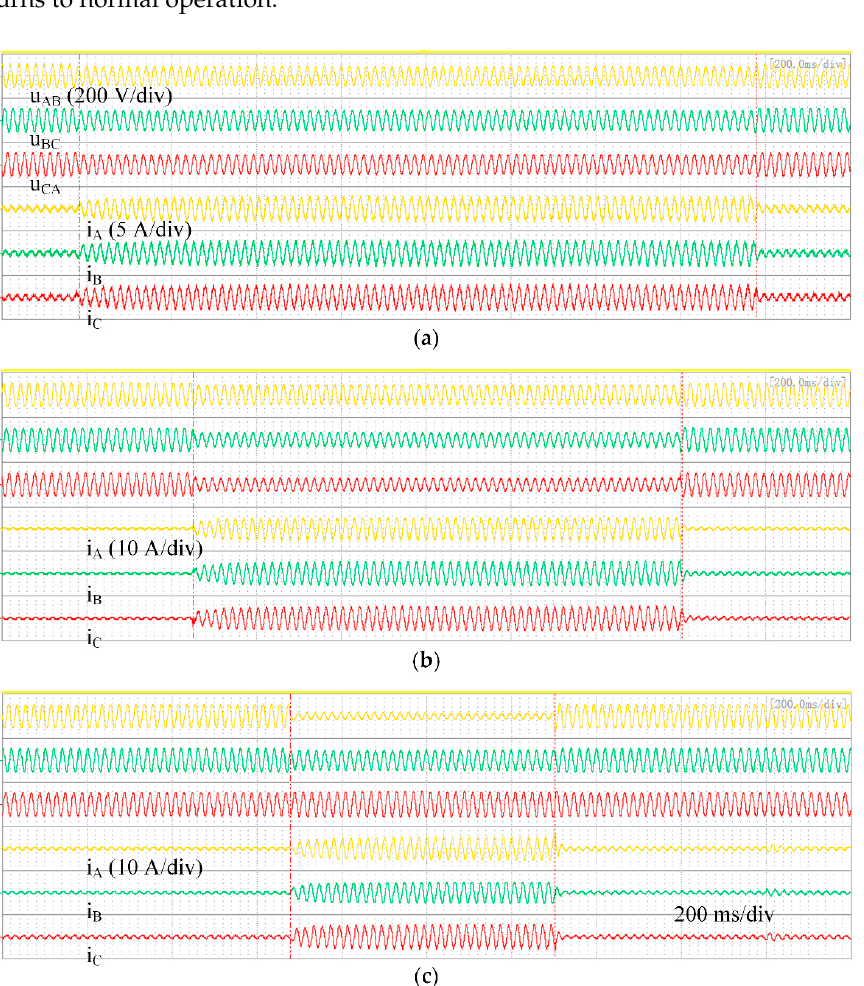
Figure 11. Output three-phase line voltage and current waveforms of PV inverter during LVRT testing. ( a ) Under three-phase 80% sag, 1.55 s; ( b ) Under phase-BC 50% sag, 1.1 s; ( c ) Under phase-A 20% sag, 0.625 s.